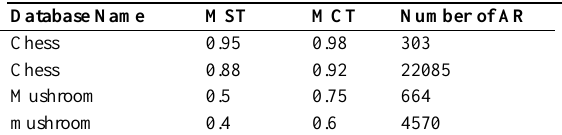
Table 10. Amount of applied MCT and MST.